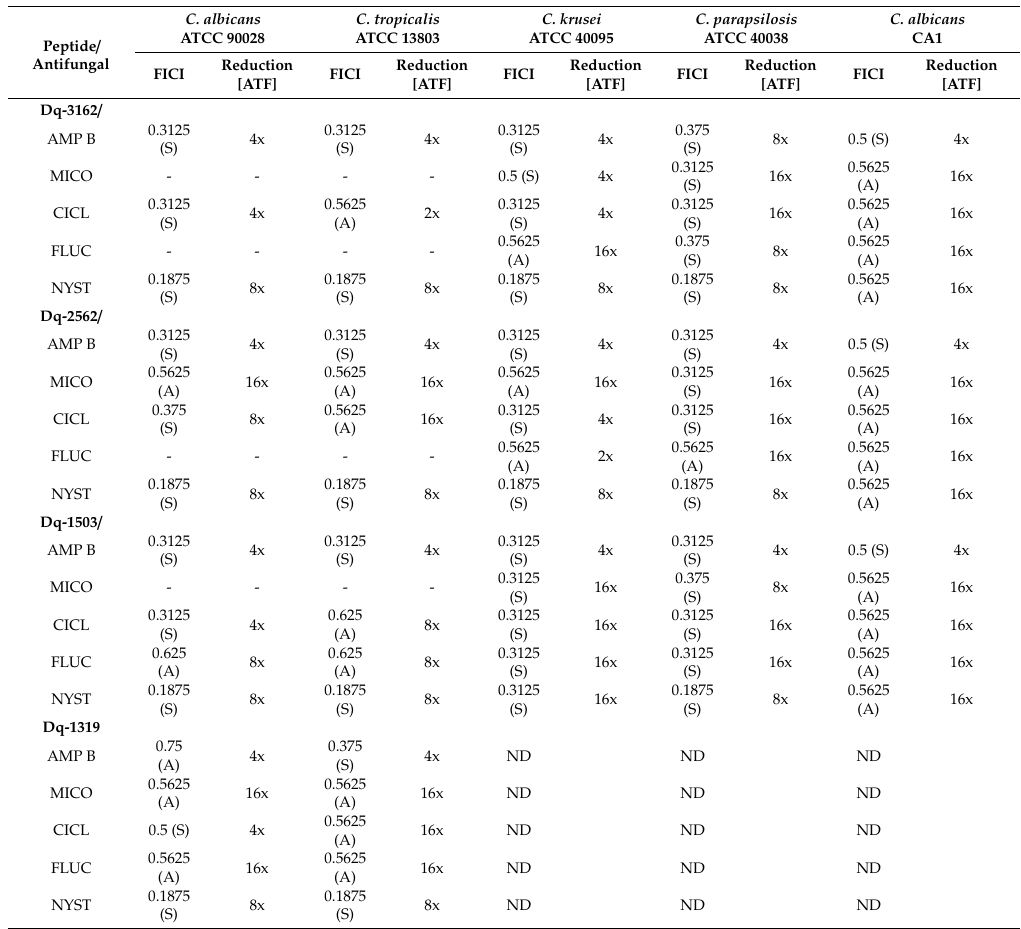
Table 3. Modulatory antifungal activity of synthetic pilosulin- (Dq-2562, Dq-1503, and Dq-1319) and ponericin-like (Dq-3162) peptides in combination with general antimycotics on the growth of pathogenic